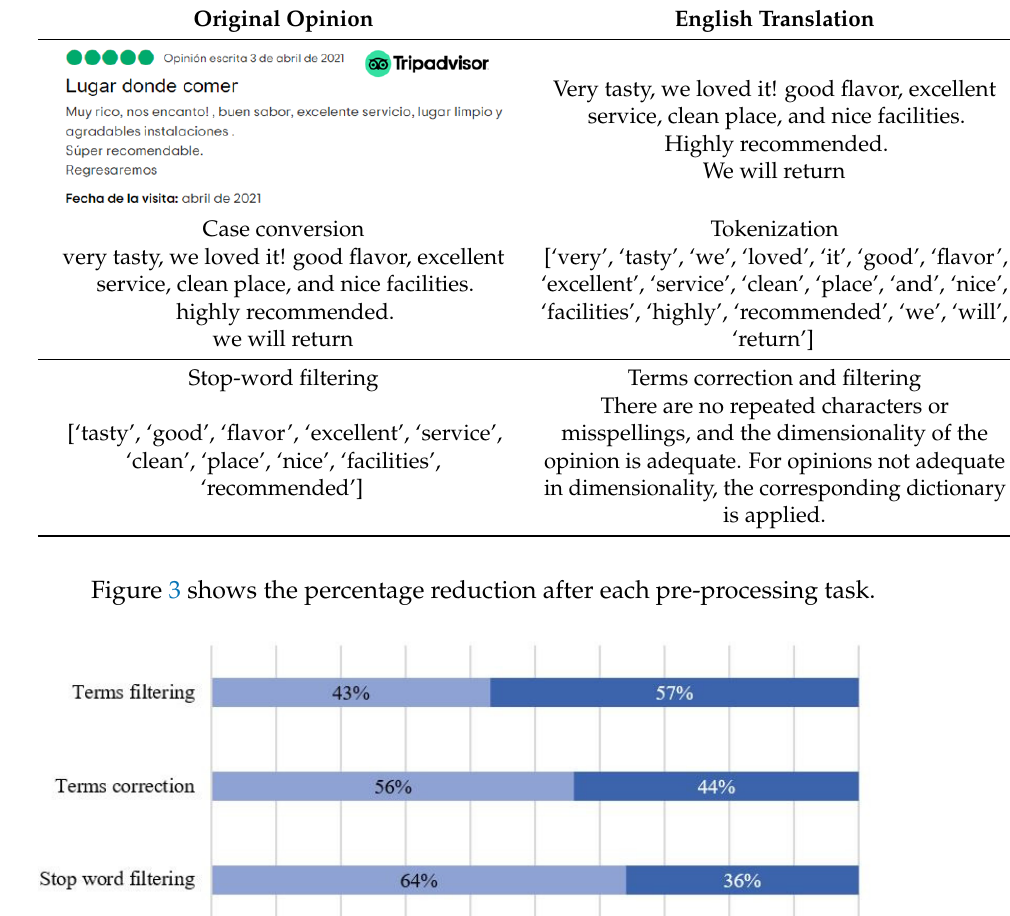
Table 2. Pre-processing steps of a real opinion.